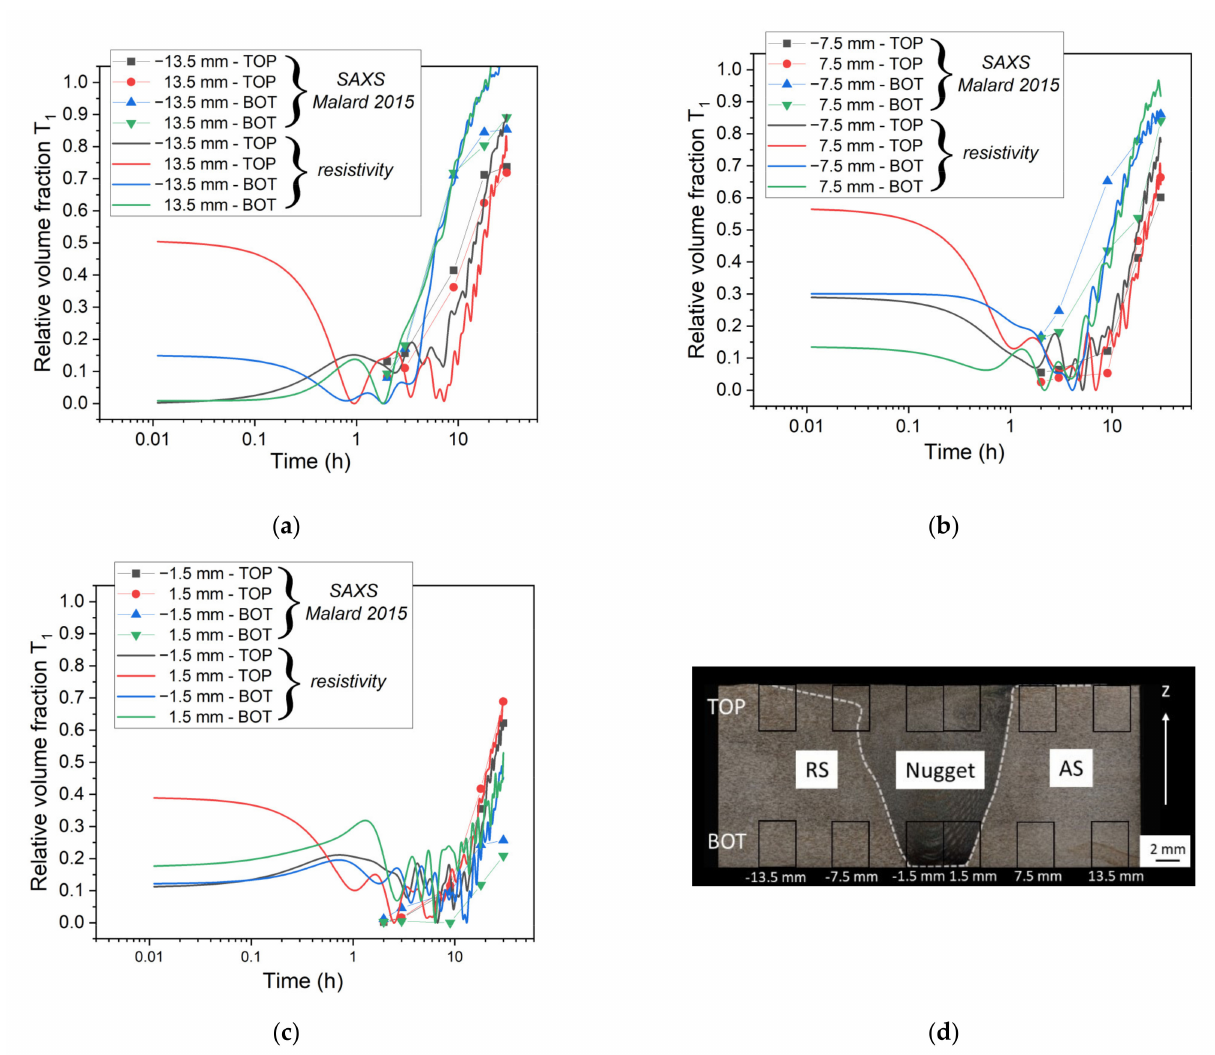
Figure 4. The evolution of the relative volume fraction of the T 1 phase measured by SAXS by Malard et al. [6] and by electrical resistivity (this study) at the top (TOP) and the bottom (BOT) of the weld joint during the post-welding heat treatment at 155 ◦ C and at ( a ) 13.5 mm; ( b ) 7.5 mm; and ( c ) 1.5 mm of the weld center. The measurement locations are shown in ( d